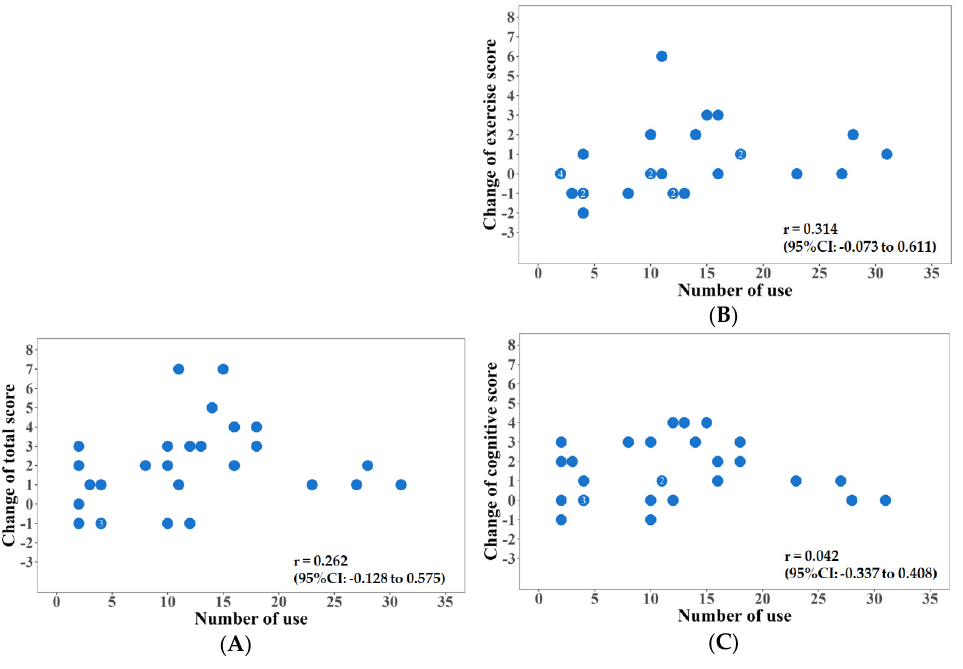
Figure 3. ( A ): relationship between the amount of change in the total FIM score and the number of times the choisoko is used. ( B ): the relationship between the amount of change in the FIM exercise score and the number of times the choisoko is used. ( C ): the relationship between the amount of change in the FIM cognitive score and the number of times the choisoko is used.